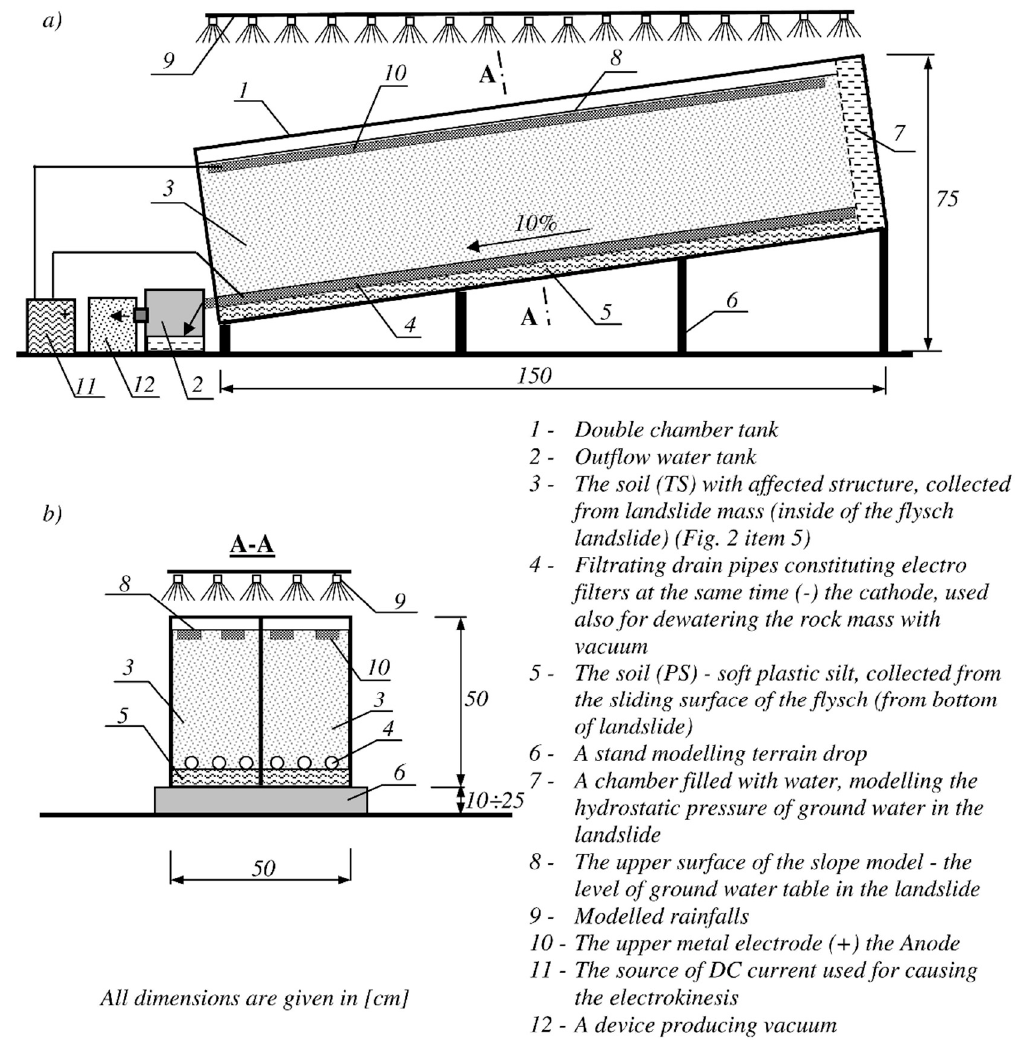
Figure 5. Diagram of the model test soil for testing the flysch landslide stabilization: ( a ) side view, ( b ) cross section A-A.